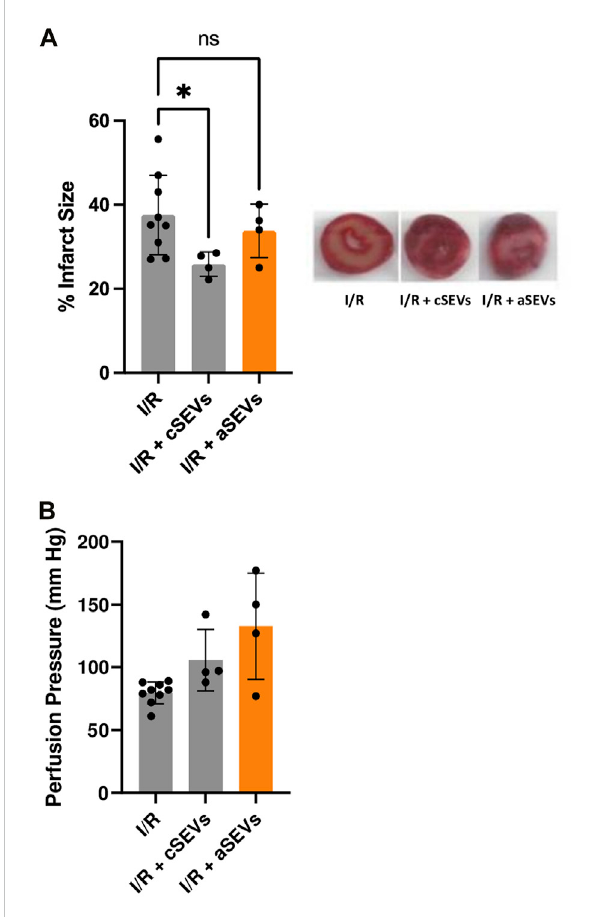
TNF- α impairs the function of endothelial SEVs in the setting of cardiac ischemia/reperfusion injury. (A) Infarct size with their respective representative images and (B) Perfusion pressure of isolated mice hearts treated with vehicle (n = 9), 1 × 10 8 of cSEVs (n = 4) or aSEVs (n = 4) for 10 min before 35 min of global ischemia, followed by 120 min of reperfusion. I/R: ischemia/reperfusion, ns: not signi fi cant. * p < 0.05 vs. I/R. Mean ±